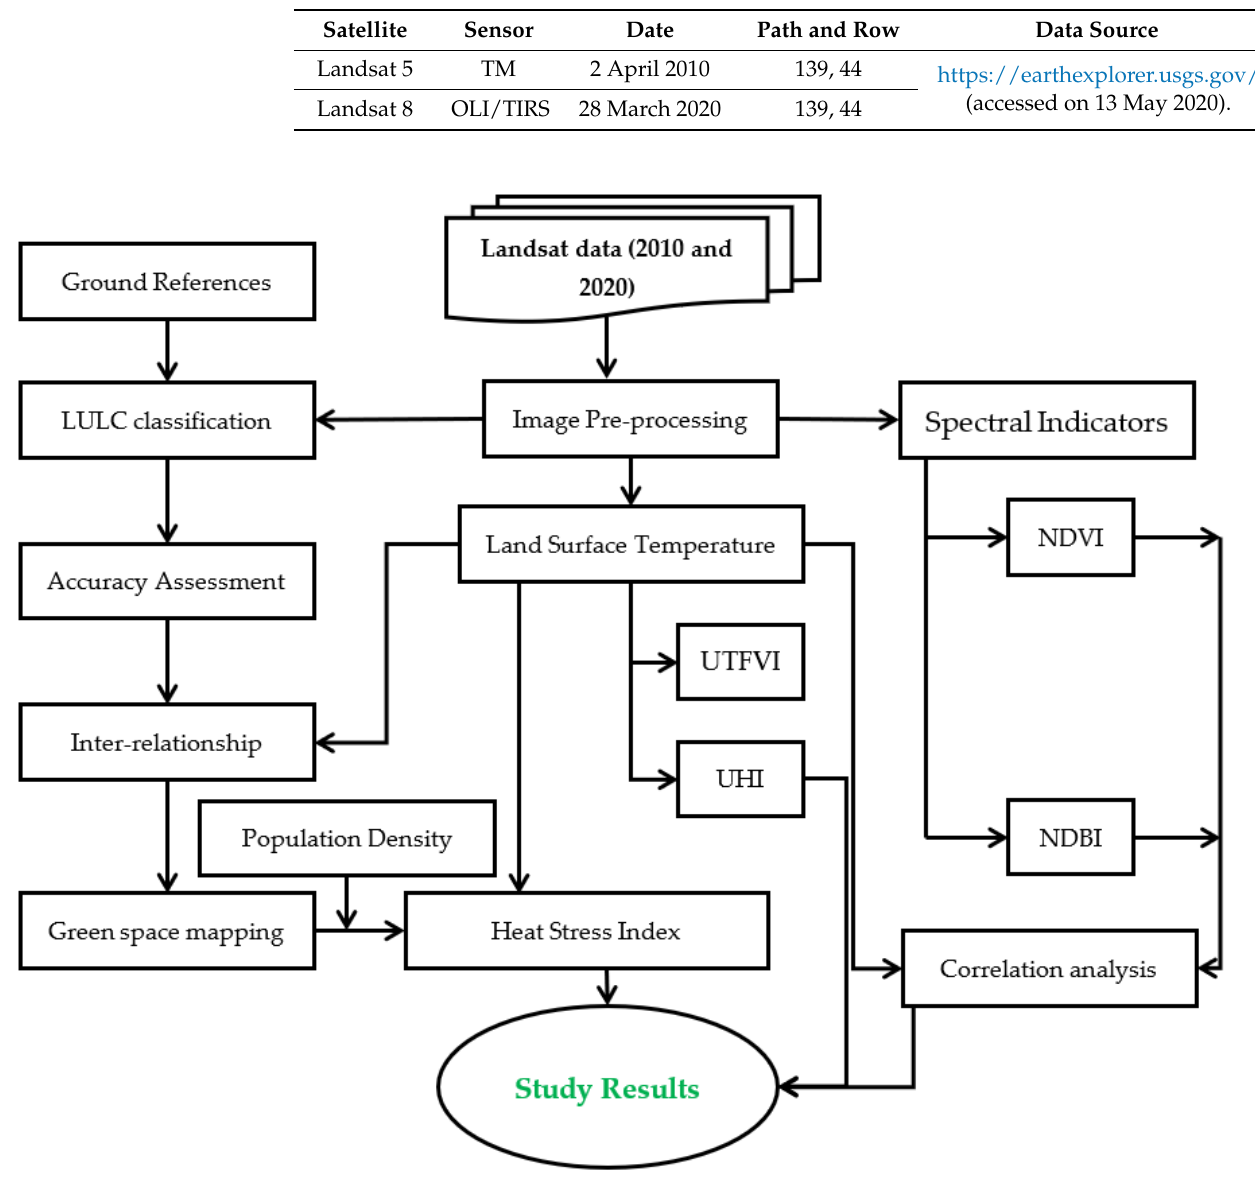
Figure 3. Adopted methodology of this study. Table 1. Details of the satellite data and acquisition date.